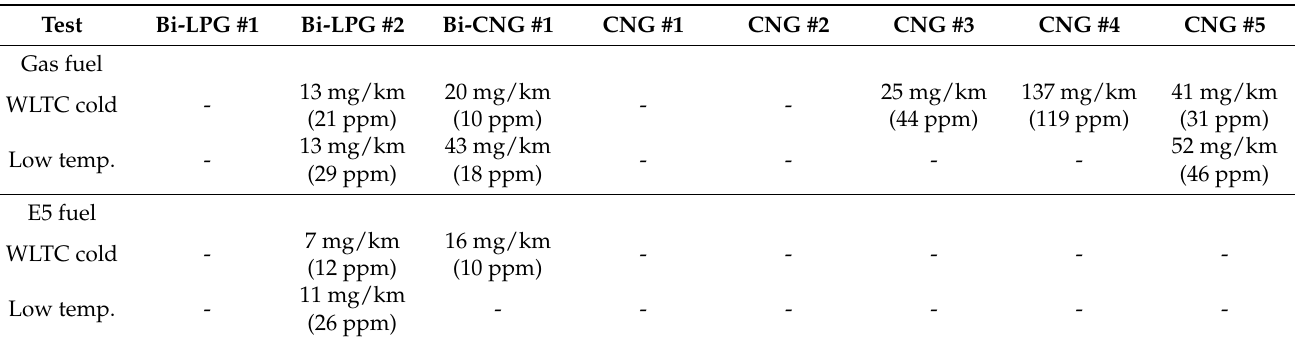
Table 4. Ammonia (NH 3 ) emissions in the